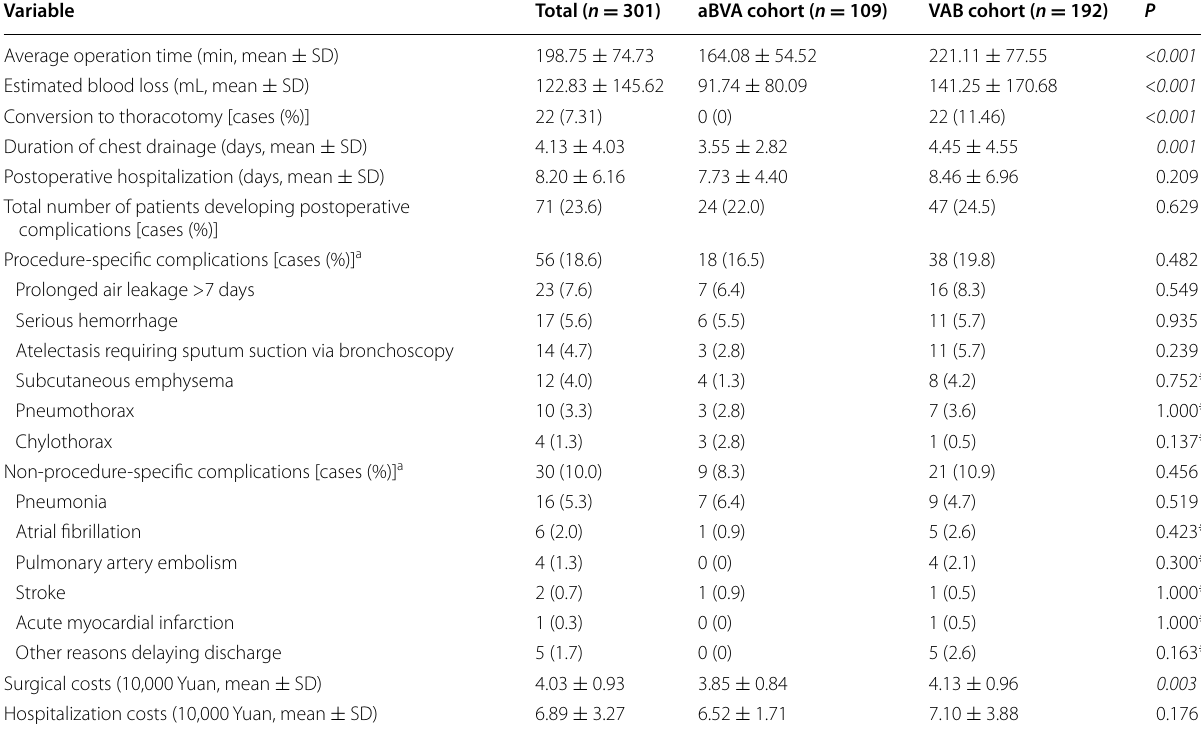
aBVA RUL with the dissecting order of the posterior ascending arterial branch [a], followed by the right upper bronchus [B] and pulmonary vessels [VA]; VAB RUL with the dissecting order of the right upper pulmonary veins and arteries [VA], followed by the right upper bronchus [B]; SD standard